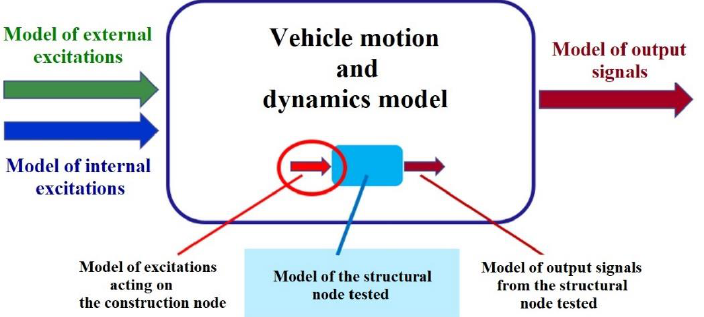
Figure 2. Determining the forces that act on the tested node of the vehicle structure (the drawing has been based on the author’s own drawing presented in the publication [14]).